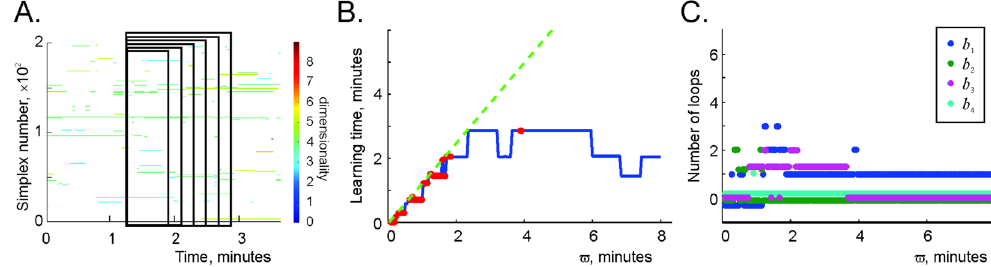
Figure 6. Stability the large-scale topological information. ( A ) A schematic illustration of the growing coactivity window ϖ , superimposed over a fragment of the maximal simplex’ timeline diagram on Fig. 4A. ( B ) The learning times T min ( t k ) computed within the growing coactivity window are shown by the blue line. For narrow coactivity windows, the learning times either diverge ( T min ( t k ) > ϖ ) or converge barely ( T min ( t k ) ≈ ϖ ). As ≈ 4–6 minutes), the learning time ϖ exceeds a certain critical value ϖ ϖ c (for the simulated place cell ensemble, c T min ( t k ) stops increasing and begins to fluctuate around a certain mean value T min = 〈 T min ( t k ) 〉 k . This value is independent of the coactivity window width and hence represents a parameter-free characterization of the mean time required to extract topological information from place cell coactivity. ( C ) The low-dimensional Betti numbers b 1 , b 2 , b 3 and b 4 as a function of the coactivity integration window width ϖ . As ϖ exceeds a critical value ϖ c , the Betti numbers b n stabilize, indicating suppression of the topological fluctuations in  ϖ